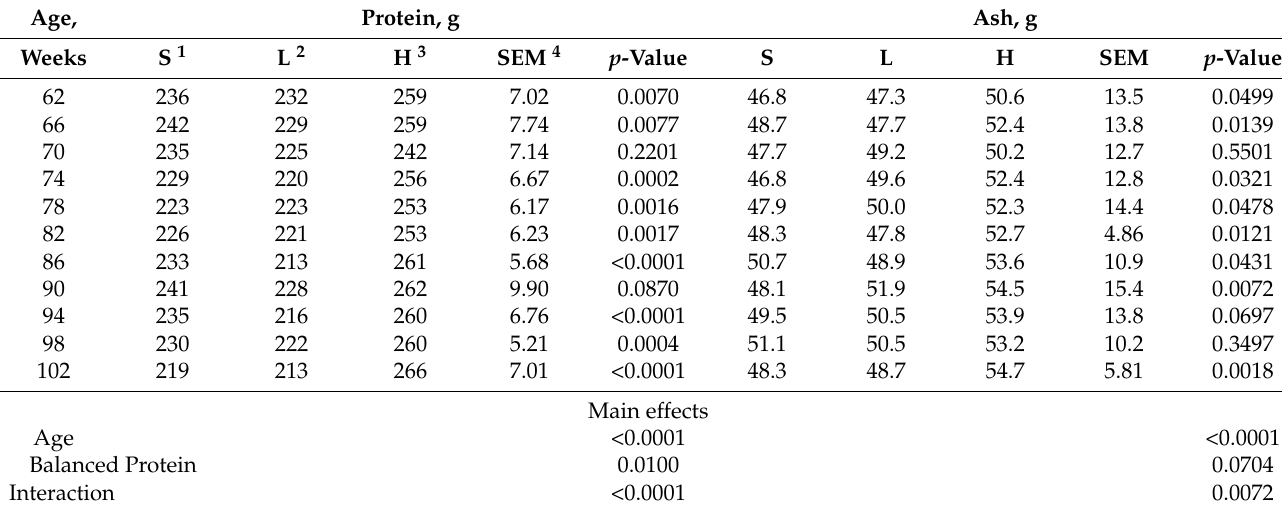
Table 8. Coefficients from linear plus exponential equation for body weight and body composition of laying hens from 8 to 102 weeks old in response to age in three dietary balanced protein levels.